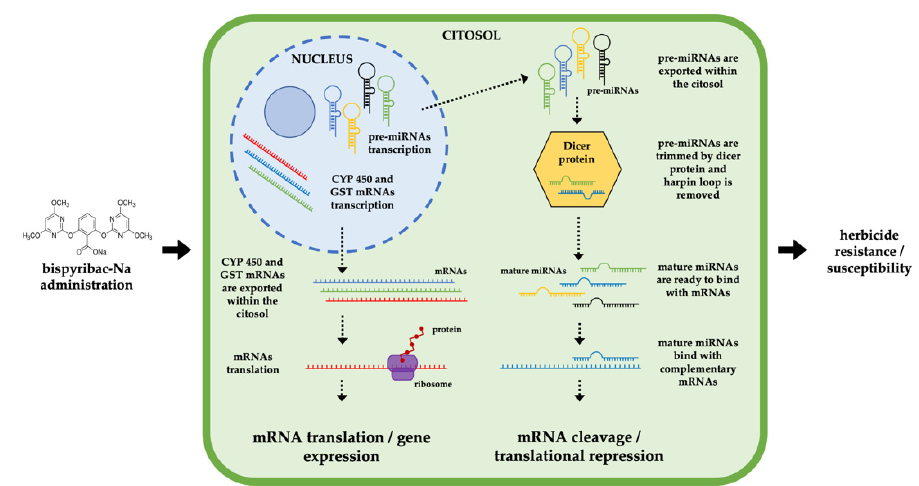
Figure 3. The role of miRNAs in the adaptive response of plants to bispyribac-sodium.